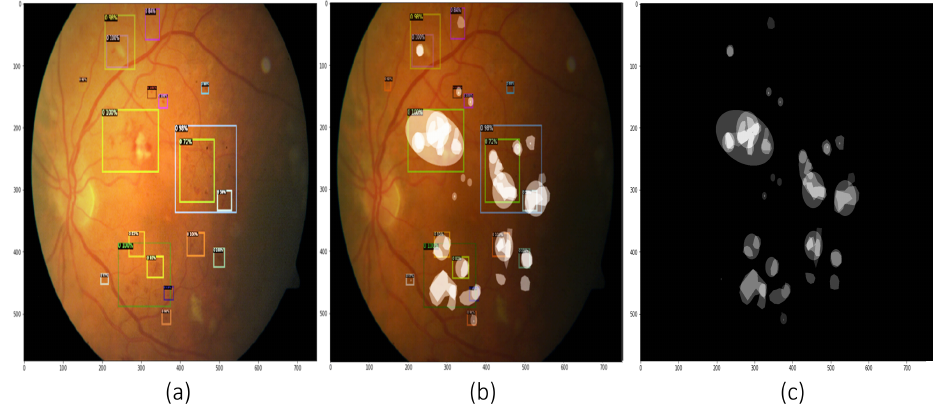
Figure 7. The results of Faster R-CNN (R-50-FPN) can be visually compared to the ground truth to assess the performance of the model. ( a ) Shows the output image from Faster R-CNN (R-50-FPN), ( b ) Shows the ground truth image overlayed on the output image, and ( c ) Shows the ground truth image marked by experts. The visual comparison of the model’s predictions to expert annotations offers an objective evaluation of the model’s accuracy and sensitivity. It highlights any discrepancies or errors in the model’s predictions and provides insight into the degree of agreement between the model’s predictions and the expert annotations.